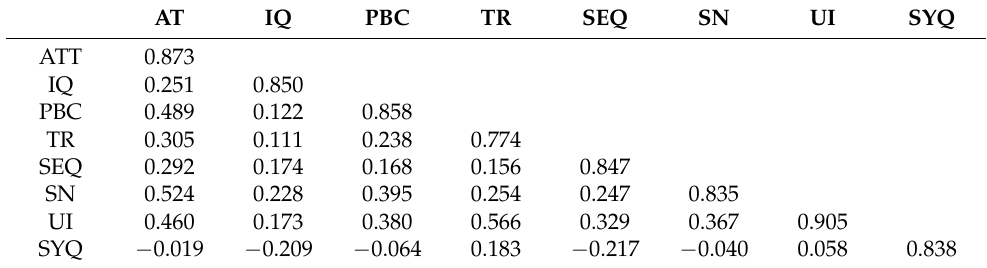
Table 3. Discriminant validity (entire